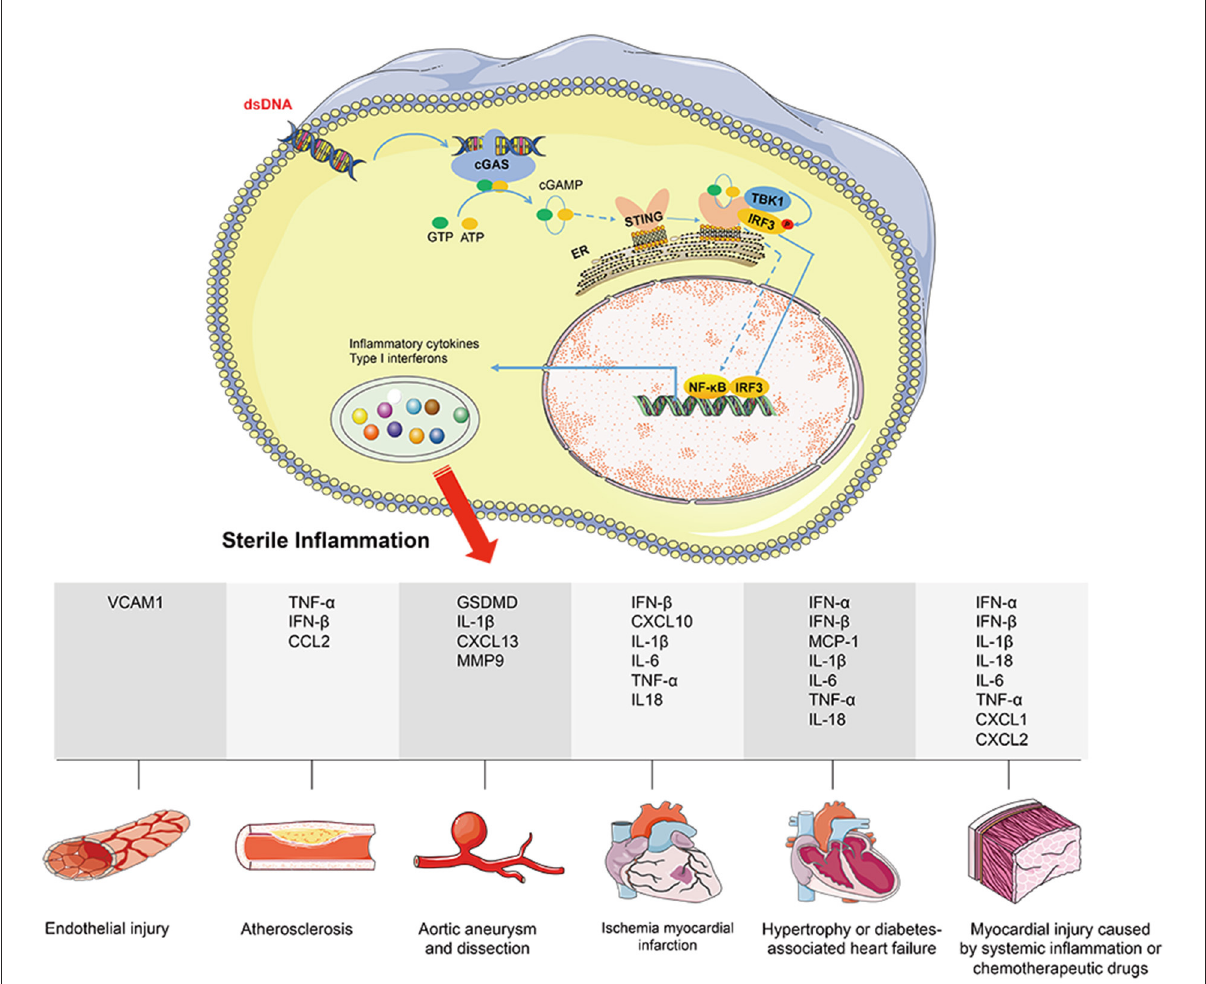
FIGURE2 cGAS-STING signaling activation mediates cardiovascular diseases via promoting sterile inflammation. Under cardiovascular pathological conditions, disrupting DNA compartmentalization and/or its metabolism leads to cGAS-STING signaling activation. Nuclear transcription of IRF3 or NF- κ B promotes the expression of downstream inflammatory factors (including VCAM1, GSDMD, CCL2, CXCL1, CXCL2, CXCL10, CXCL13, TNF- α , IL-1 β , IL-6, IL-18, MCP-1, MMP9, IFN- α , and IFN- β ), eventually leading to the inflammatory response. Herein, the pathological process of cardiovascular diseases regulated by cGAS-STING-driven inflammation includes endothelial injury, atherosclerosis, aortic aneurysm and dissection, ischemia myocardial infraction, hypertrophy or diabetes associated heart failure, and myocardial injury caused by systemic inflammation or chemo therapeutic